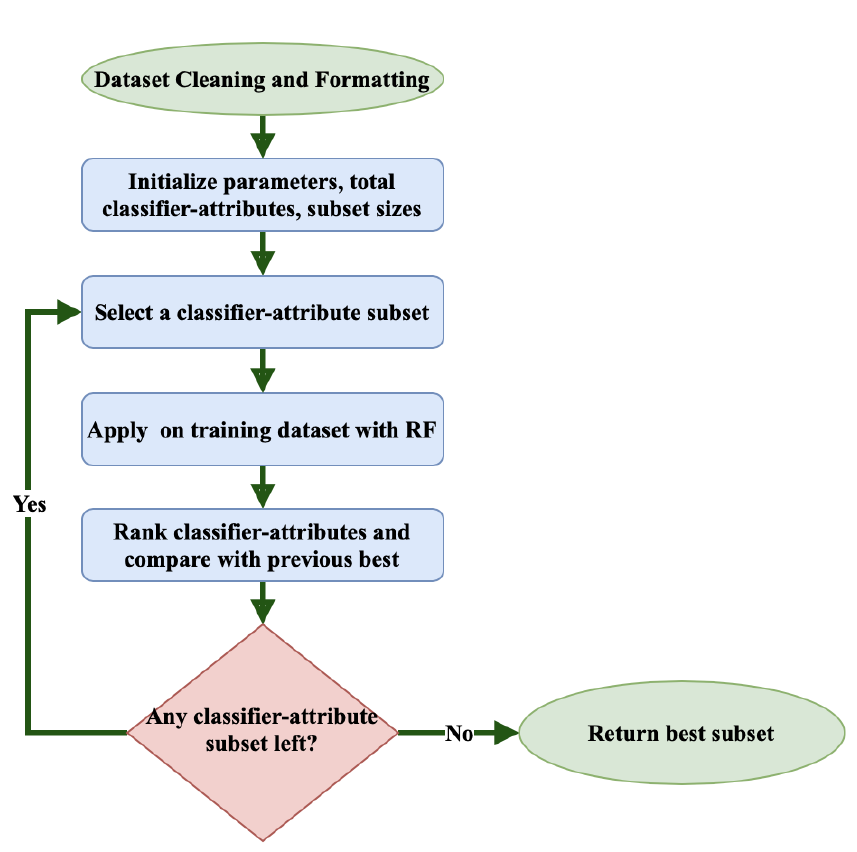
Figure 2. Workflow diagram of Recursive Feature Elimination